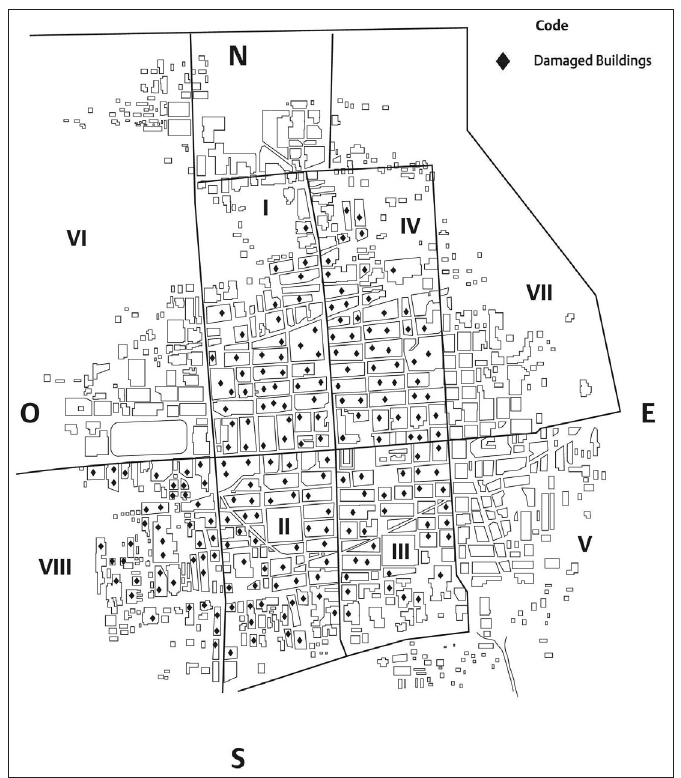
Fig. 3. Effects of the 7 April 1845 earthquake in Mexico